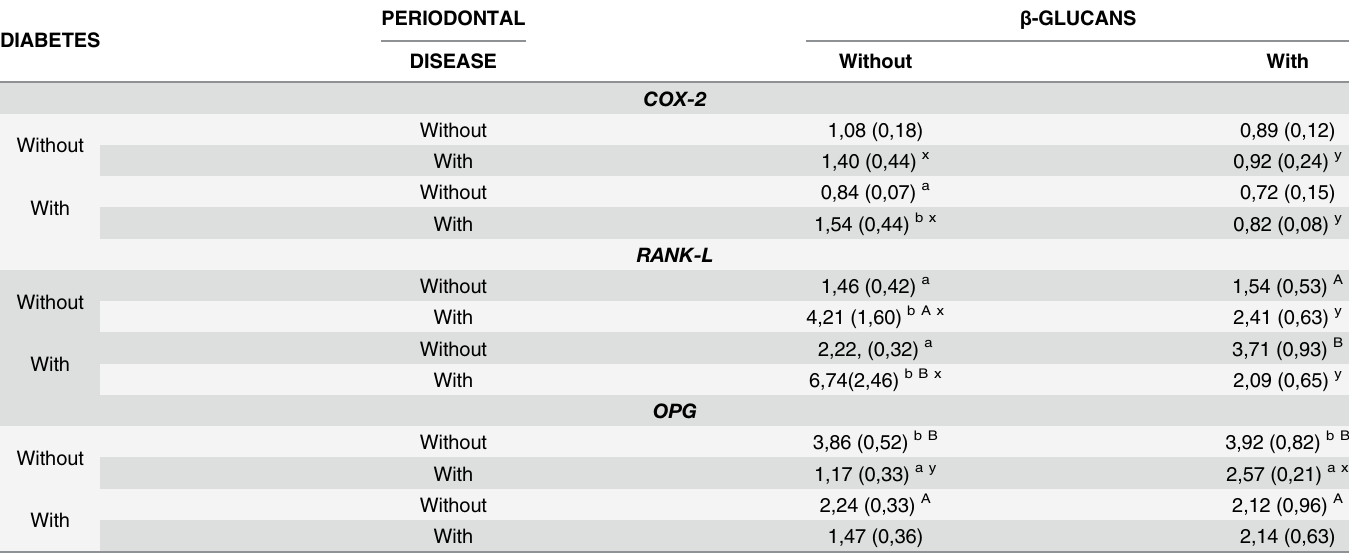
With A,B Means followed by different letters in columns indicate signi fi cant differences between groups with and without diabetes by F test (p < 0,05). a,b Means followed by different letters in columns indicate signi fi cant differences between groups with and without periodontal disease by F test (p < 0,05). x,y Means followed by different letters in lines indicate signi fi cant differences between groups with and without β -glucan ingestion by F test (p <